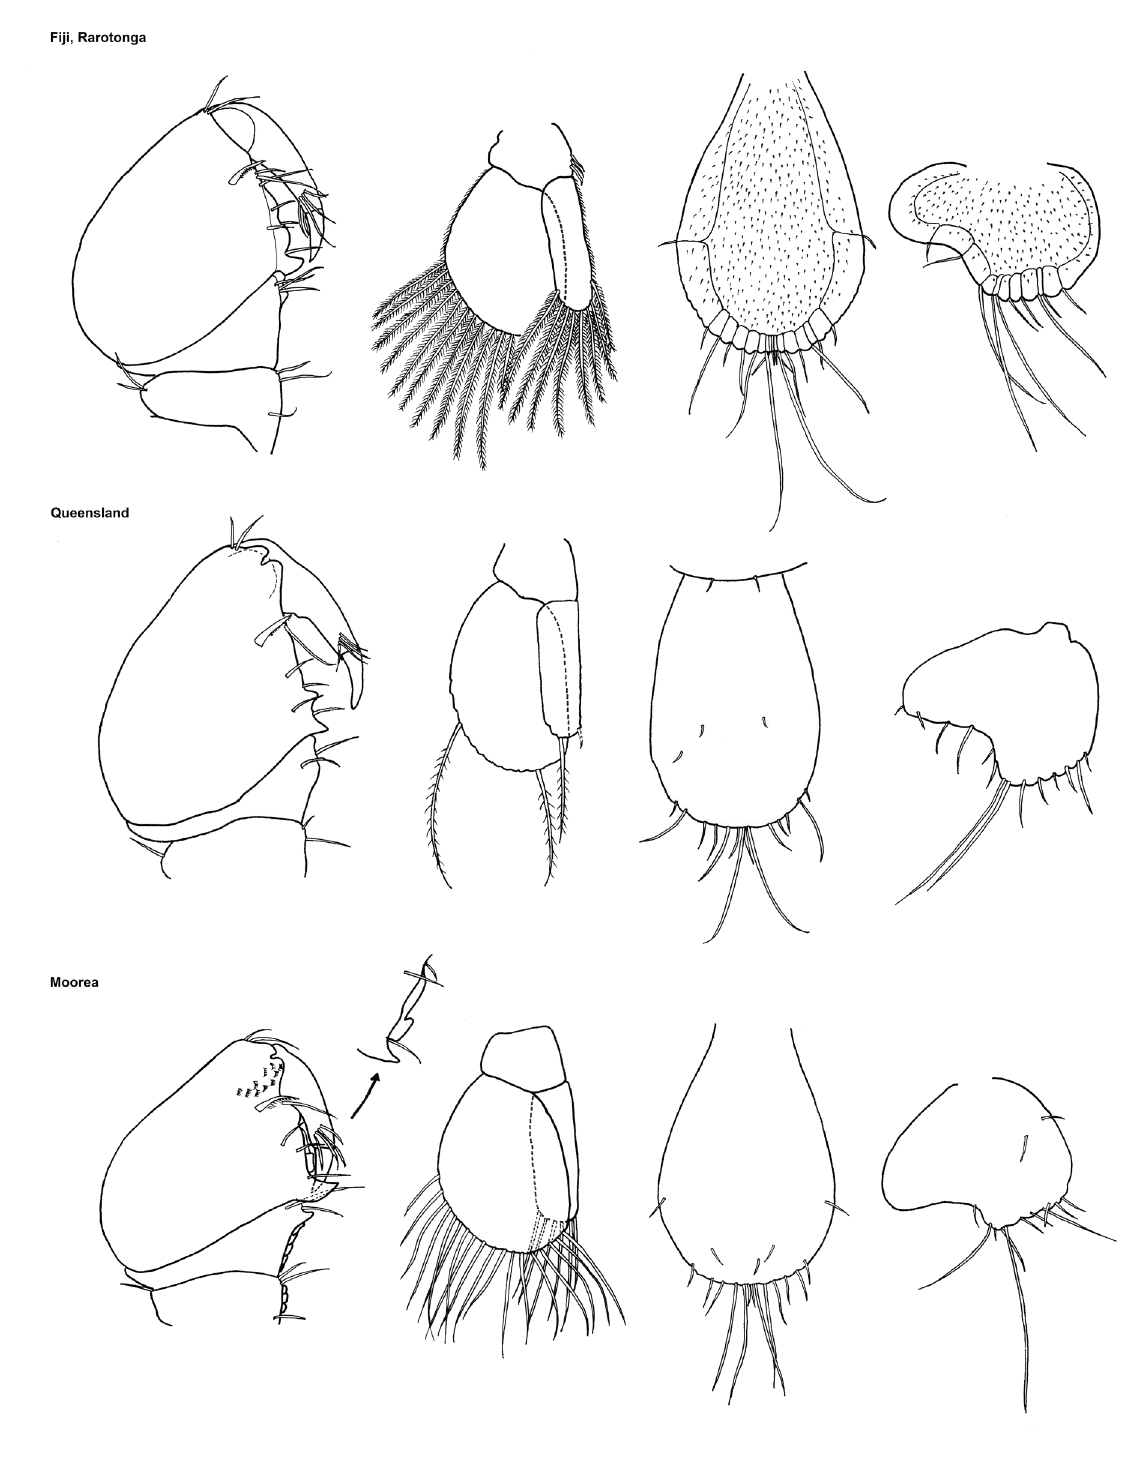
Fig. 22. Expanathura collaris (Kensley, 1979), comparison of published descriptions. Pereopod 1, pleopod 1, telson and exopod of uropod. Populations from Fiji (after Kensley 1979), Queensland (after Poore 2002) and Moorea (after Müller